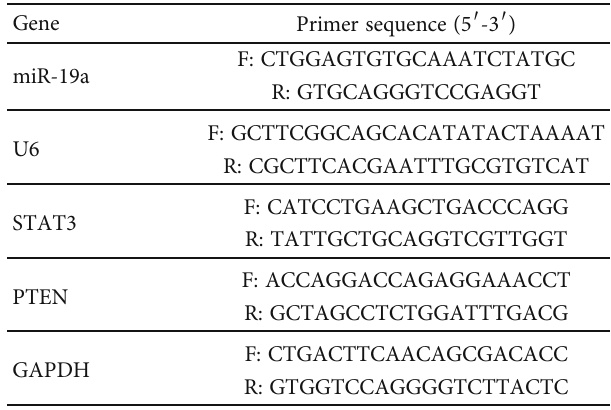
Table 1: Primer sequences for RT-qPCR. Gene Primer sequence (5 ′ -3 ′